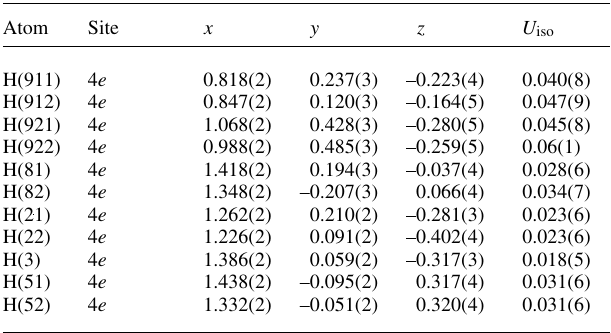
Table 2. Atomic coordinates and displacement parameters (in Å 2 )